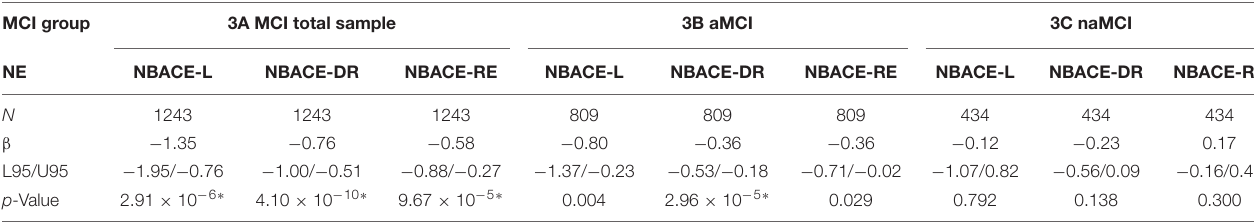
TABLE 3 | Genetic associations with NEs in the total sample, aMCI, and naMCI groups from the ACE dataset. MCI group 3A MCI total